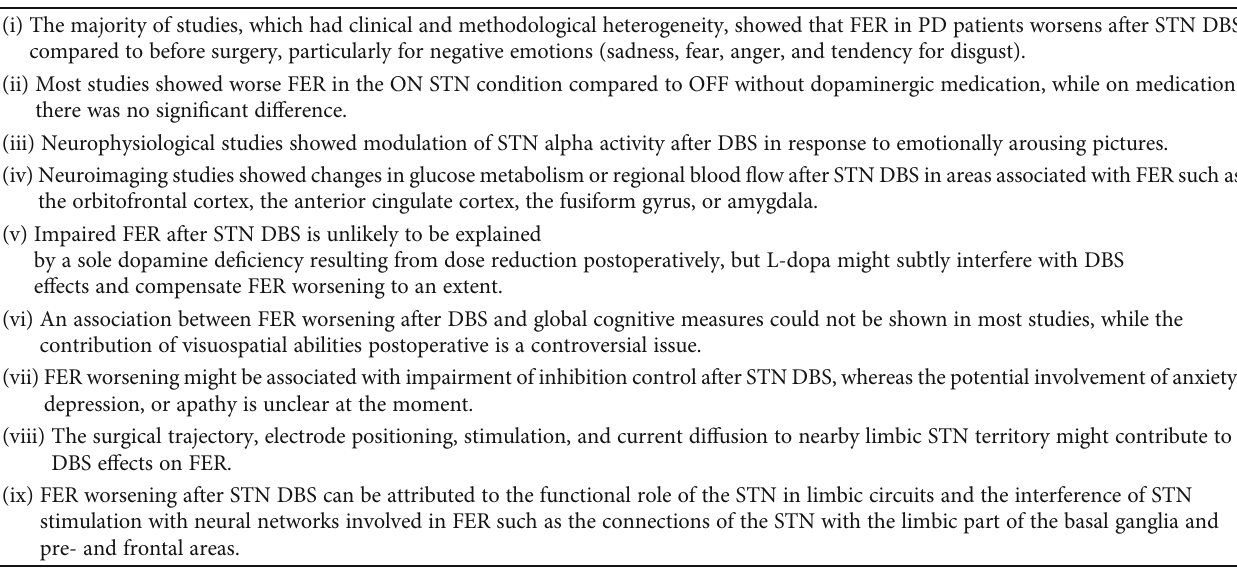
Table 2: Main fi ndings and considerations regarding the e ff ects of STN DBS on facial emotion recognition (FER) in PD. (i) The majority of studies, which had clinical and methodological heterogeneity, showed that FER in PD patients worsens after STN DBS compared to before surgery, particularly for negative emotions (sadness, fear, anger, and tendency for disgust). there was no signi fi cant di ff